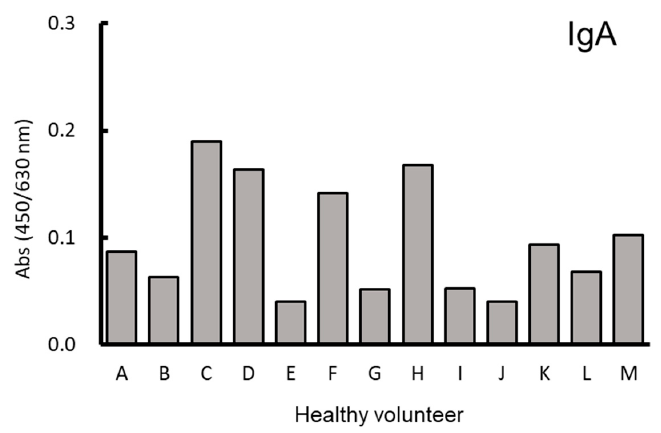
Figure 6. Reactivity of antibody against Euglena gracilis EOD-1 paramylon (EOD1PM) in saliva of healthy human volunteers. An ELISA plate was coated with sEOD1PM and blocked. Human saliva samples ( n = 13) were diluted, and the amount of plate-bound Ig was determined using peroxidase-conjugated anti-human IgA antibody. Each column represents data from one individual.